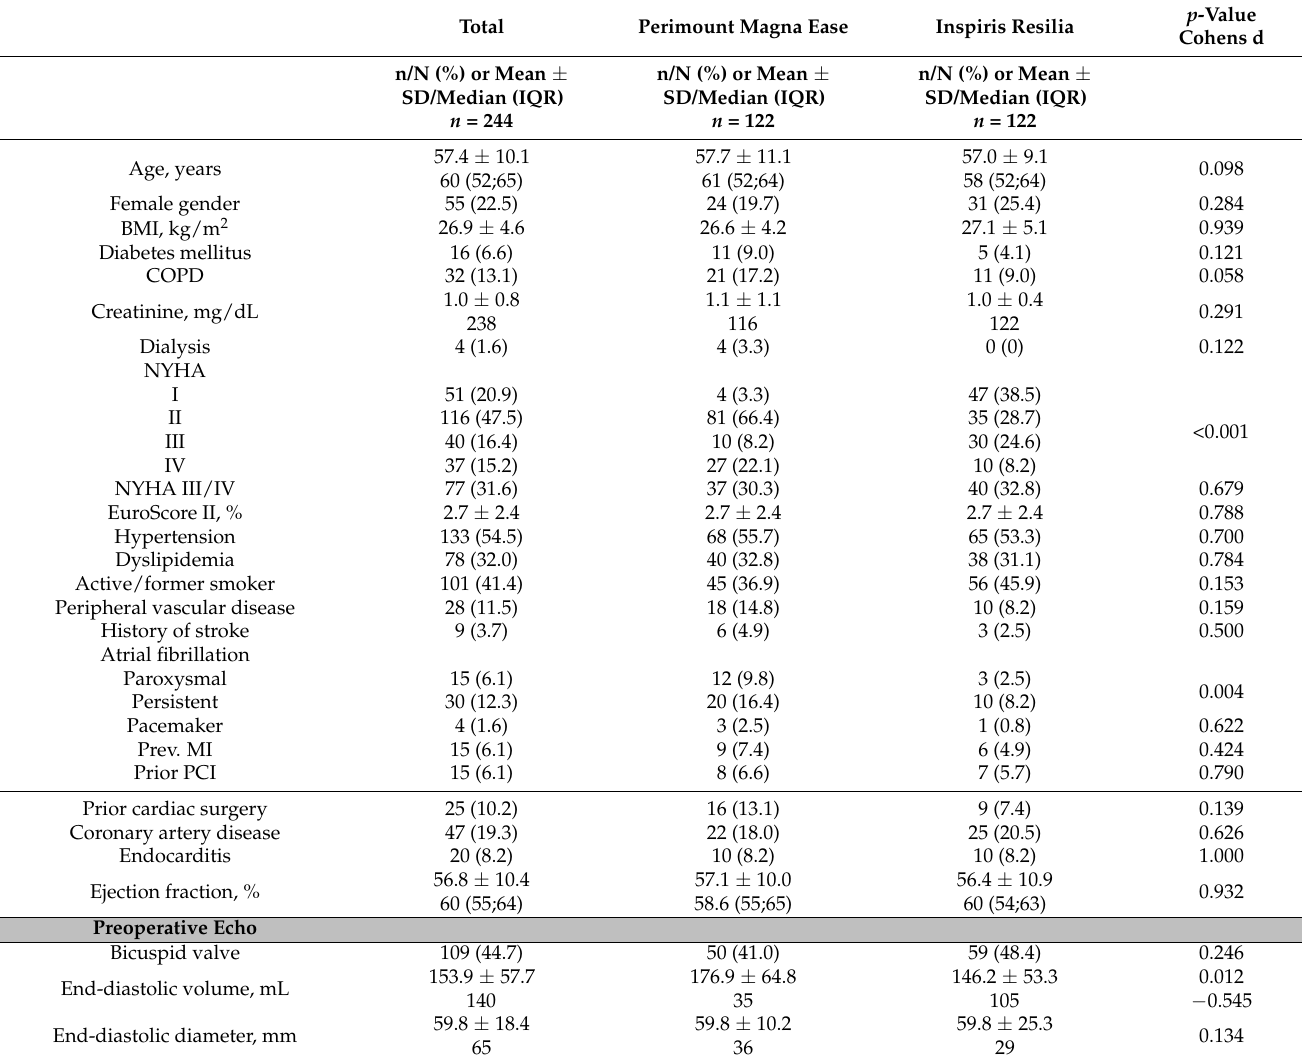
Table 1. Patient characteristics: Propensity Score matched